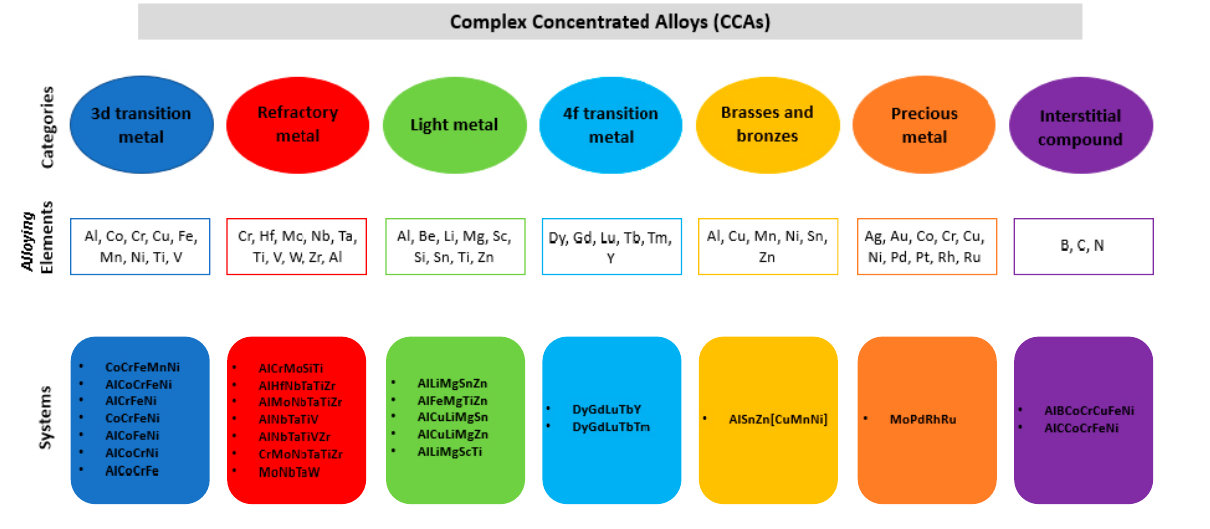
Figure 2. Illustration of the studied CCAs categories sorted by elemental groupings as Senkov et al. defined in their work